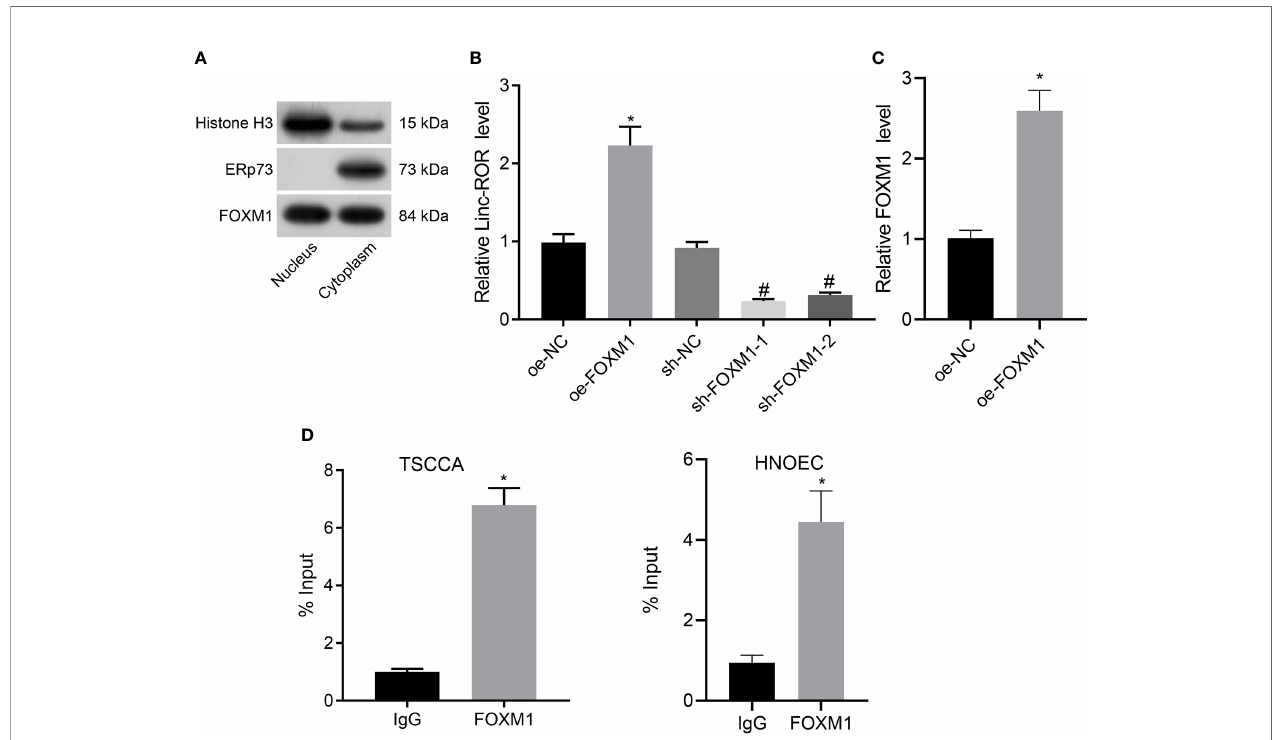
FIGURE 3 | FOXM1 upregulates the expression of Linc-ROR in TSCCA cells. (A) Measurement of the enrichment degree of FOXM1 protein in the puri fi ed nucleus and cytoplasm. Histone H3 was considered as a nuclear marker, ERp72 was used as a cytoplasmic marker; (B) The expression of Linc-ROR in TSCCA cells by RT- qPCR, * p < 0.05, compared with the oe-NC group, # p < 0.05, compared with the sh-NC group; (C) Binding of FOXM1 to the promoter region of Linc-ROR in TSCCA cells determined by dual-luciferase reporter assay, * p < 0.05, compared with the oe-NC group; (D) The af fi nity of FOXM1 for the promoter of Linc-ROR in TSCCA and HNOEC/HL-047 cells determined by ChIP assay, and IgG as a negative control, * p < 0.05, compared with the IgG group. All experiments were repeated three